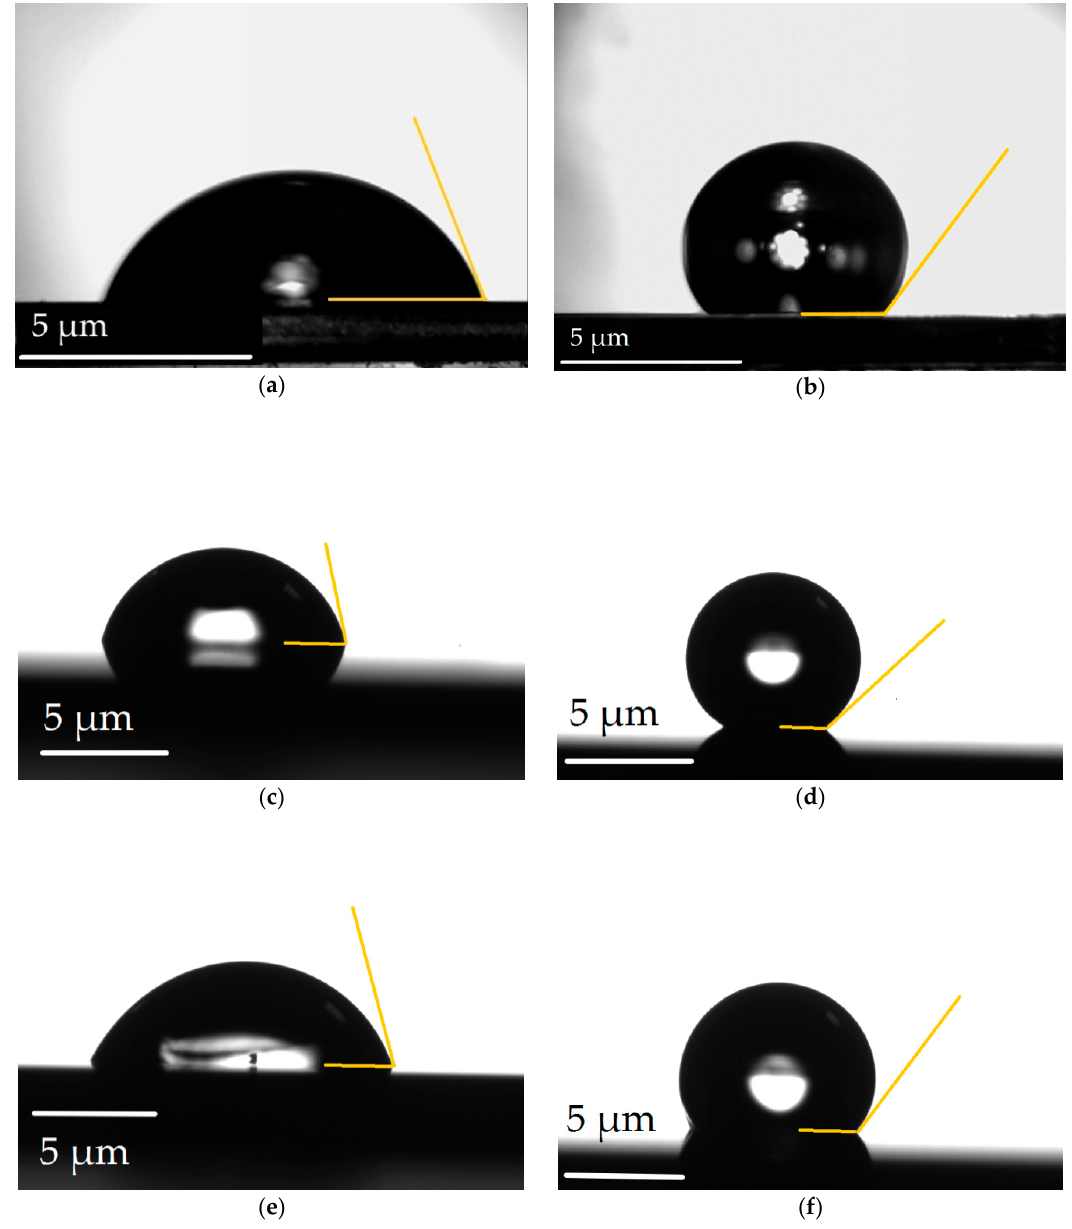
Figure 3. The image of the droplet of distilled water on the surface of: ( a ) 15×(Ti/Zr) on Si (Ti is the topmost layer), as-deposited, the CA = 72.11°; ( b ) 15×(Ti/Zr) on Si (Ti is the topmost layer), laser-modified, the CA = 137.15°; ( c ) 15×(Zr/Ti) on Si (Zr is the topmost layer), as-deposited, the CA = 77.29°; ( d ) 15×(Zr/Ti) on Si (Zr is the topmost layer), laser-modified, the CA = 144.49°; ( e ) 8×(Zr/Cr/Ti) on Si (Zr is the topmost layer), as-deposited, the CA = 68.10°; ( f ) 8×(Zr/Cr/Ti) on Si (Zr is the topmost layer), laser-modified, the CA = 123.45°. White bar denotes 5 μ m. Golden lines are added for the visualization.